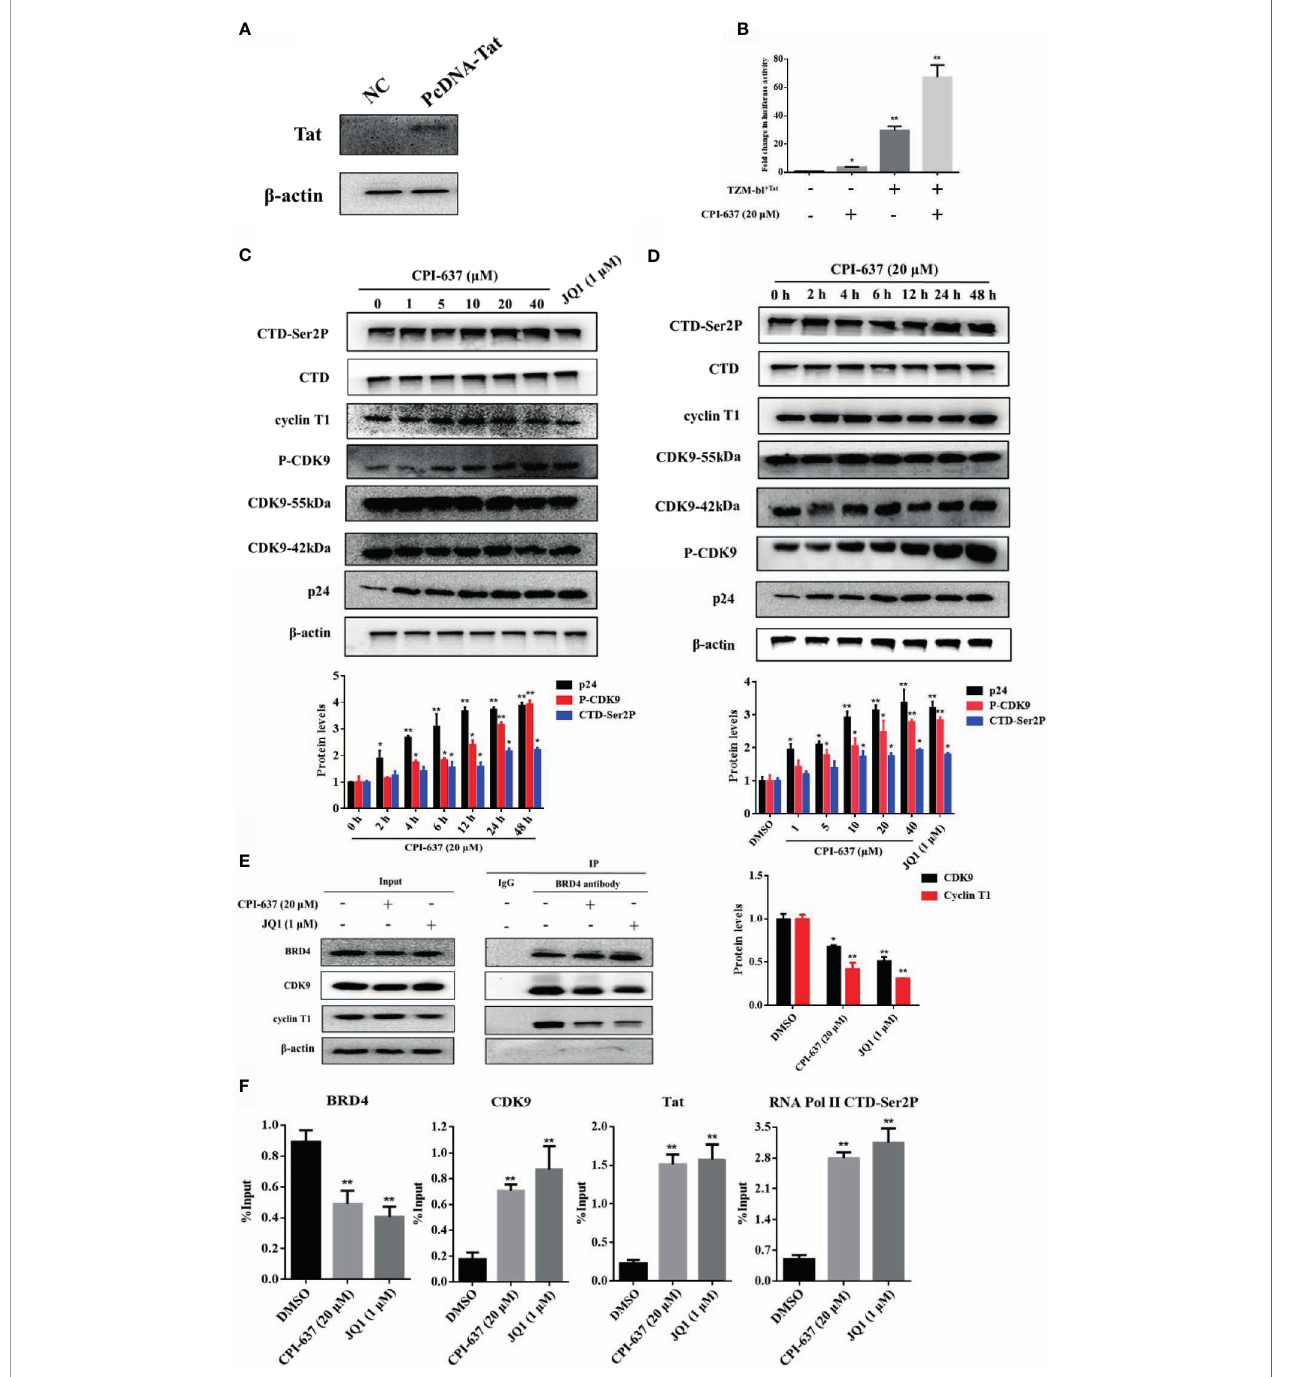
FIGURE 4 | CPI-637 promotes latent HIV-1 expression via a Tat-dependent P-TEFb pathway. TZM-bl cells containing an integrated HIV LTR-luciferase construct were nucleofected with a plasmid expressing Tat (+) or a negative control plasmid ( − ). And the expression of TIP60 in TZM-bl +Tat cells was detected by WB (A) . TZM-bl +Tat Cells were treated with CPI-637 (20 m M) for 48 h and subjected to luciferase assay (B) . ACH2 cells were treated with CPI-637 for 48 h at the indicated concentrations (C) or with CPI-637 (20 m M) at the indicated time points (D) , and then the expressions of CTD, CTD-Ser 2P, cyclin T1, CDK9, p-CDK9 and p24 were analyzed by WB. ACH2 cells were incubated with CPI-637 (20 m M) for 48 h, recruitment of CDK9 and cyclin T1 by BRD4 was analyzed by co-IP (E) and the occupancy of HIV-1 Tat, P-TEFb, RNA Pol II CTD phosphorylation at the HIV-1 LTR promoter was determined by ChIP-qPCR assays (F) . The quanti fi cations of CDK9 phosphorylation on Thr186, CTD-Ser2 and p24 were performed in (C, D) The quanti fi cations of CDK9 and cyclin T1 were performed in (E) (* p < 0.05 vs DMSO control group, ** p < 0.01 vs DMSO control